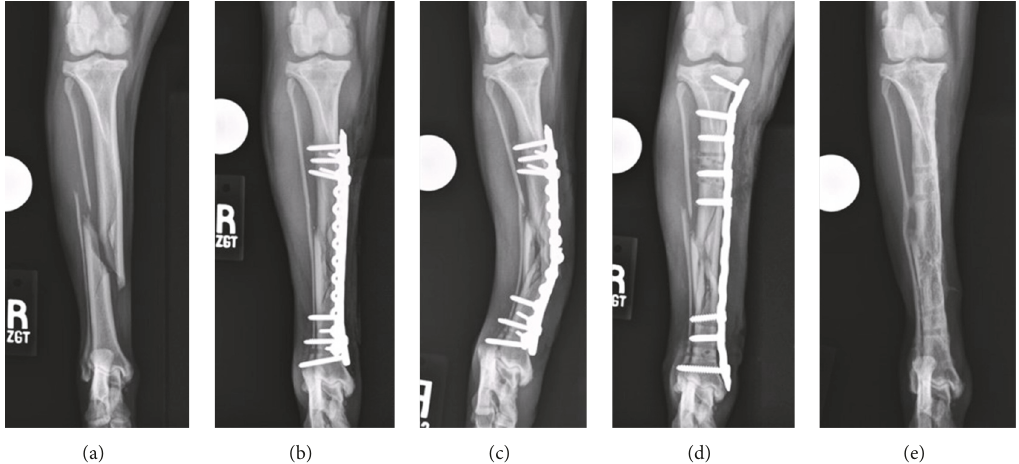
Figure 4: Craniocaudal preoperative radiographs of dog #3’s right tibial fracture (a). Initial postoperative radiographs following primary surgical stabilization with a 12-hole, 2.7 mm locking compression plate and a 10-hole, 2.0 mm String of Pearls plate (b). Implant failure was documented 7 days after surgery (c). The fracture was restabilized via application of an 11-hole, 3.5 mm LCP plate (d). Radiographs obtained 3 weeks after implant removal necessitated by infection (e).